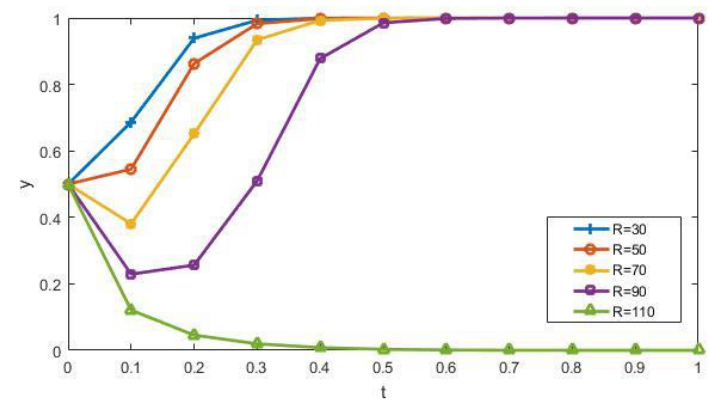
Figure 5. The impact of R on the evolutionary results.